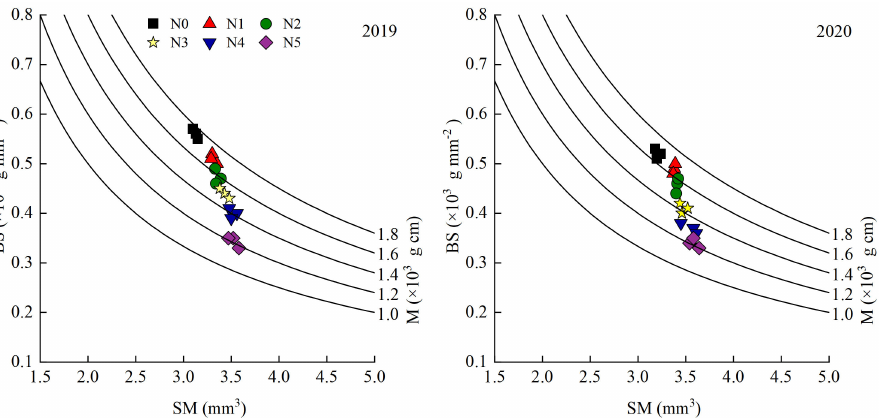
Figure 3. Relationship between SL, FW and WP of rice under dry cultivation under different N